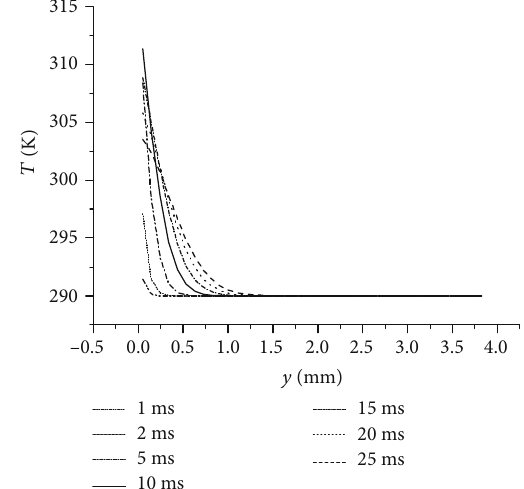
Figure 12: Temperature distribution in the case.